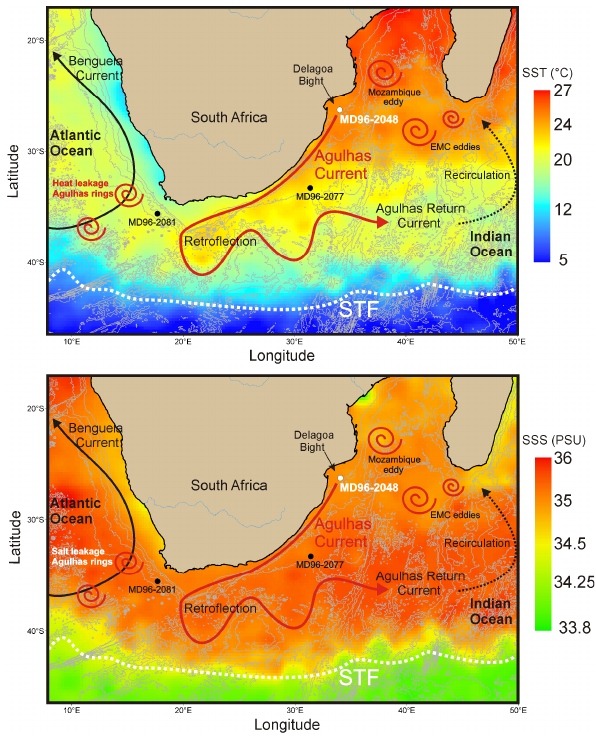
Fig. 1. Heat and salt transfer of the Agulhas surface current. (A) Sea surface temperature (SST) and (B) sea surface salinity (SSS) distribution patterns in the Agulhas system obtained from NODC WOA94 data provided by the NOAA/OAR/ESRL PSD, Boulder, Colorado, USA, from their Web site (http://www.esrl. noaa.gov/psd/). The location of core MD96-2048 (white dot) and schematic views of the Agulhas current system are indicated. The position of the Subtropical Front (STF) is indicated by the white dashed line. Locations of sediment cores MD96-2081 (Peeters et al., 2004) and MD96-2077 (Bard and Rickaby, 2009) are also in- dicated. EMC eddies refer to East Madagascar Current eddies. The bathymetry according to a 1000m step (the 1000m